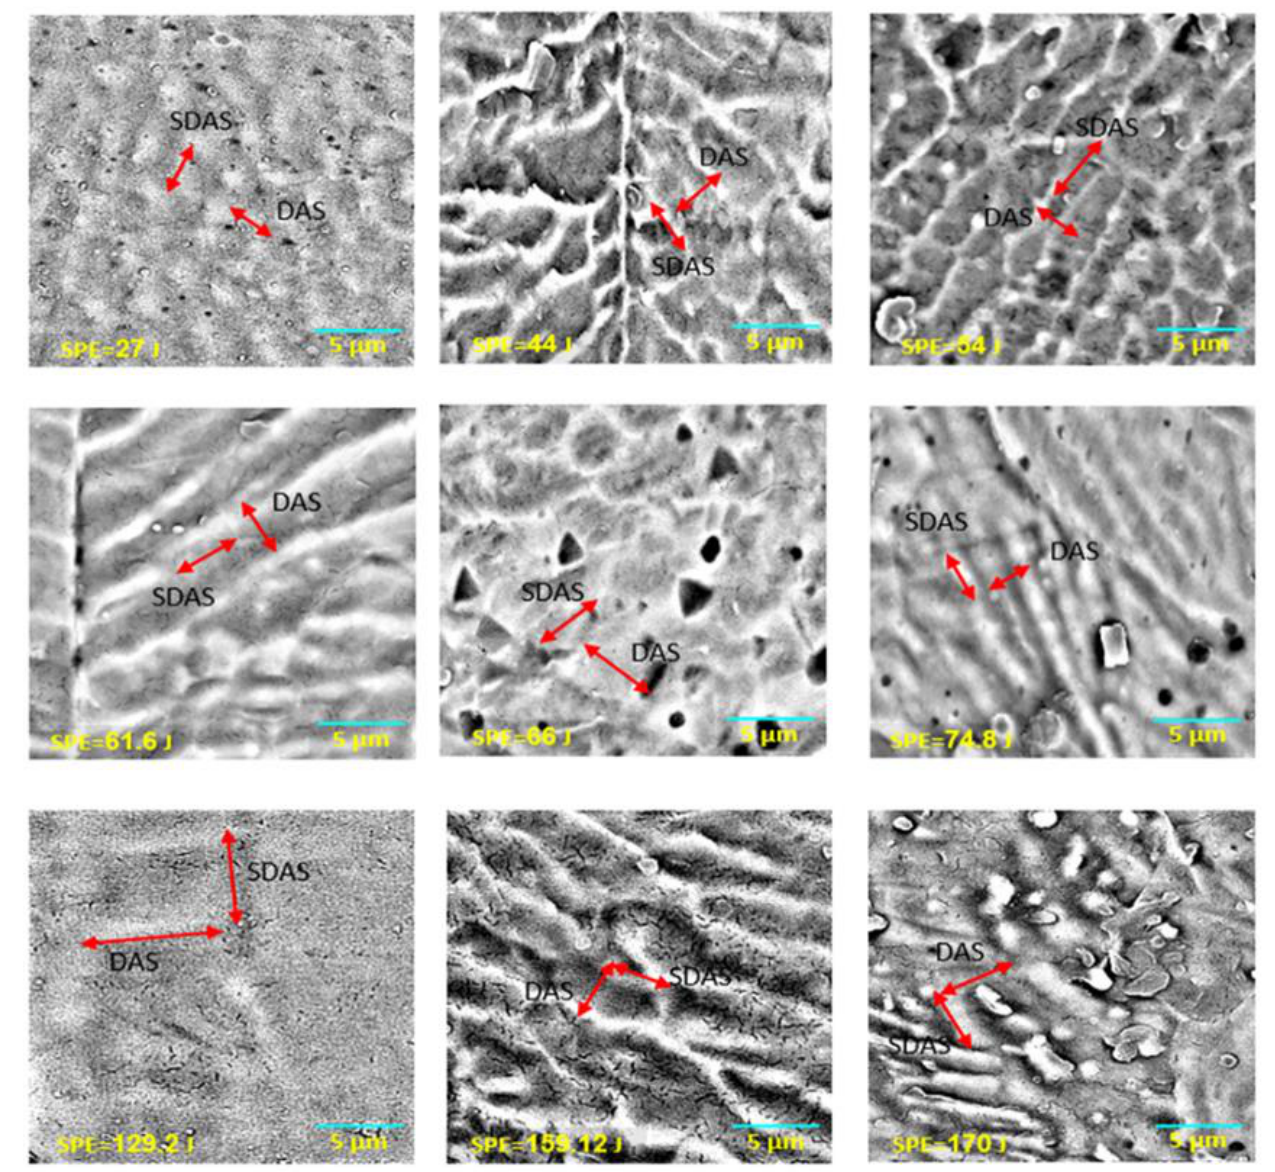
Figure 7. SEM images of the cross-section view of the 316L welded in air.